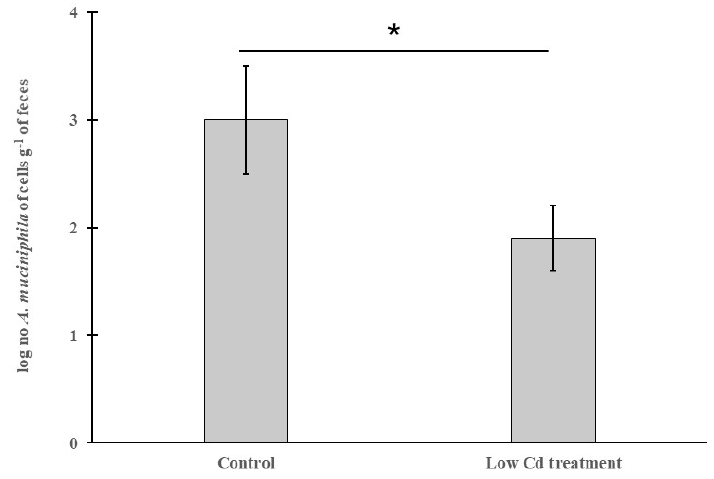
Figure 7. The relative abundance of A. mucinipbila in the control and low Cd treatment groups. * p < 0.05.